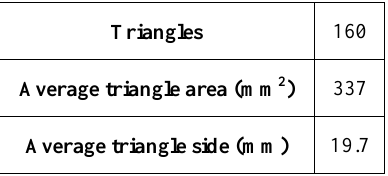
Table 2. Characteristics of the Surfaces.